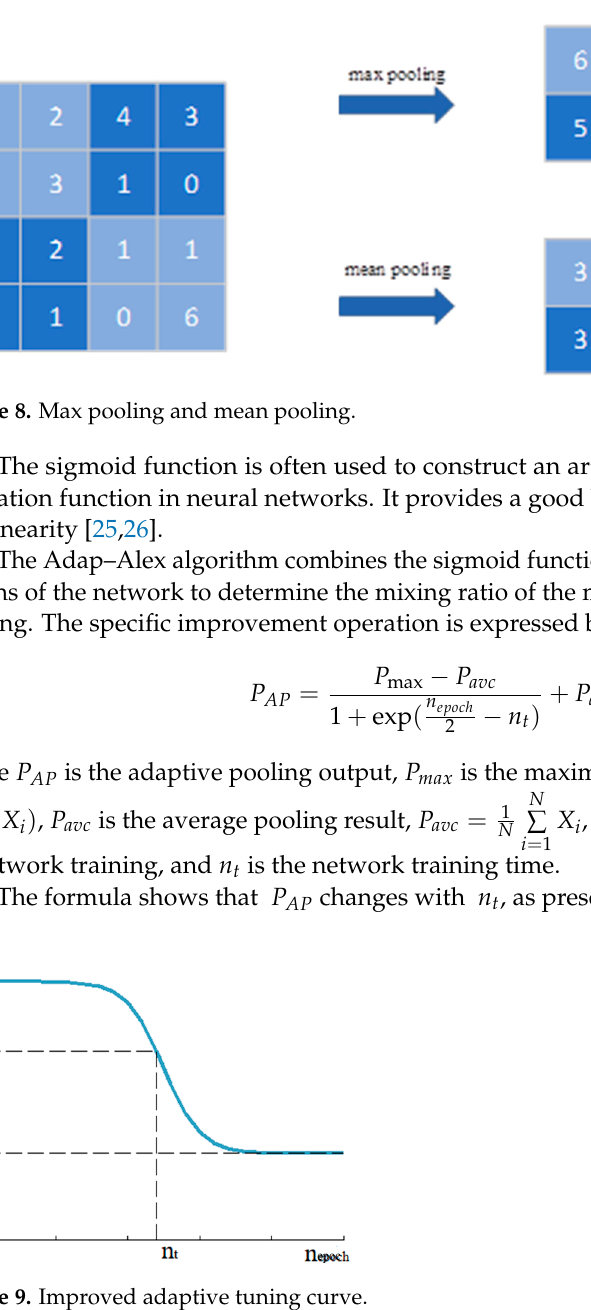
Figure 9. Improved adaptive tuning curve.